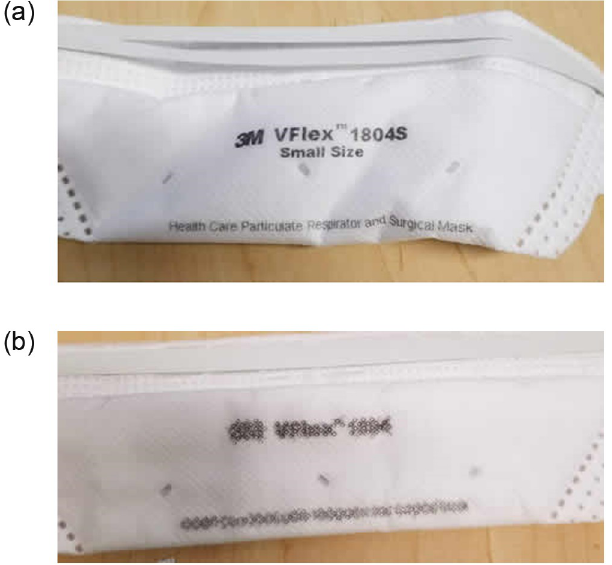
Fig 3. Impact of autoclaving on ink print on 3M 1804 filtering facepiece respirator. A single cycle of autoclaving consistently resulted in varying levels of ink bleeding on 3M 1804 and 9210 masks (a before; b after). Minimal further bleeding of ink was inconsistently observed after additional autoclave cycles. a) Before autoclave. b) After single cycle of autoclave.